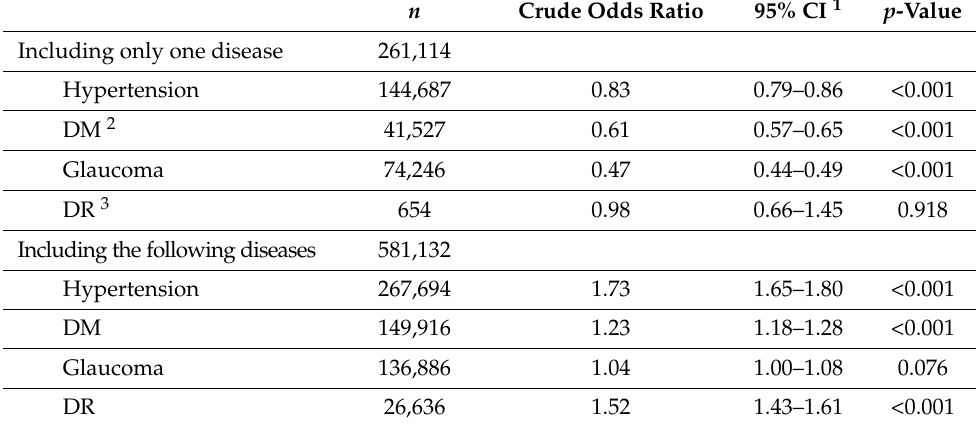
Table 6. Odds ratios for low visual acuity according to diseases associated with reduced visual